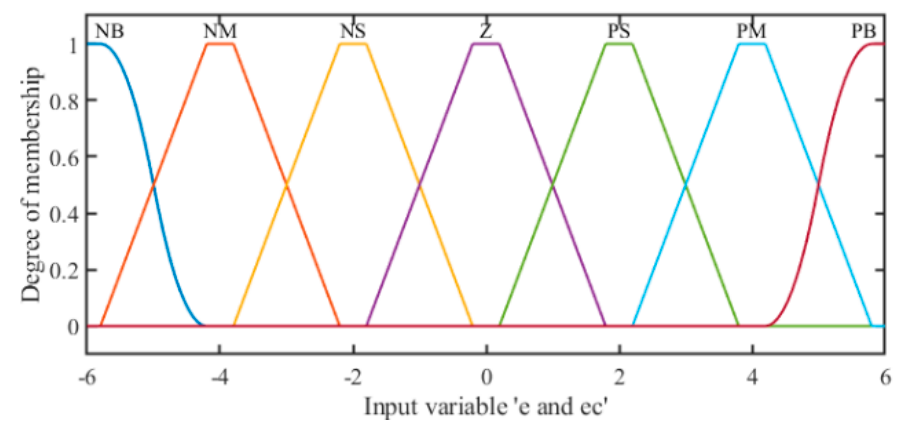
Figure 4. Membership functions of E and E C .